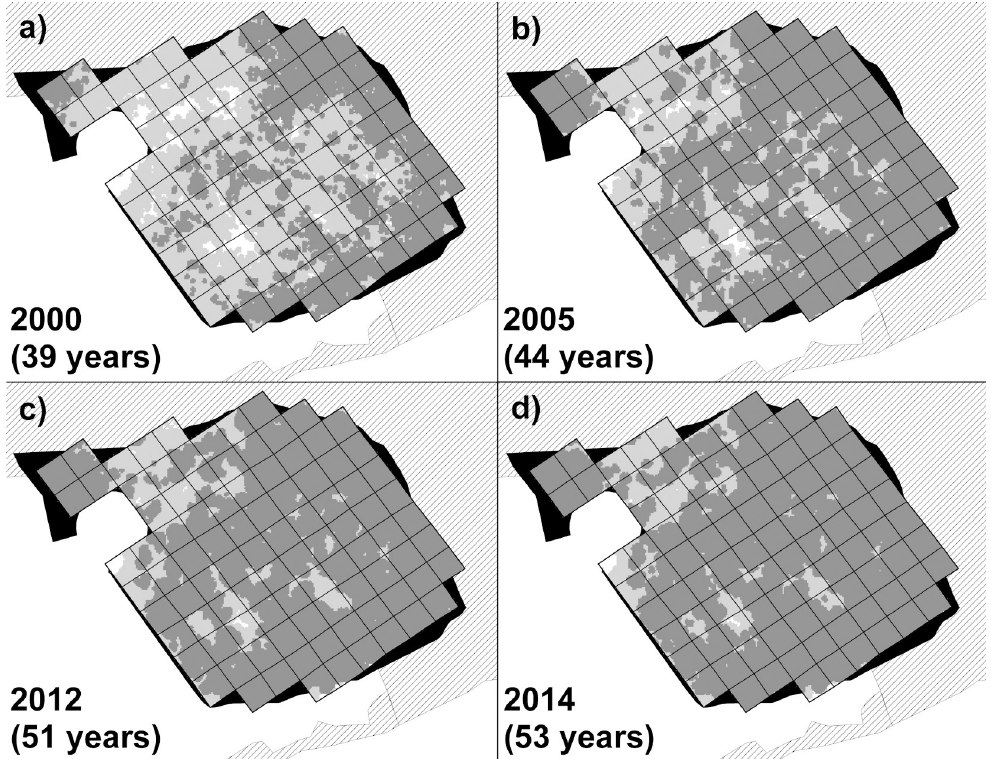
Fig 2. Development of the Old Wilderness vegetation. a) to d): Time series of remote sensing (lidar) data for the Old Wilderness for data collected in a given year (and number of years since Wilderness abandonment in 1961). Pale grey areas denote extent of woody vegetation of � 0.5 m but below 8 m tall, dark grey areas denote vegetation � 8 m tall (overstorey tree canopy). White areas are grass/herb vegetation below 0.5 m tall. Black areas denote unstudied parts of the Old Wilderness area. Hatched areas are Monks Wood ancient woodland and associated mature hedgerow (see Fig 1). Grid cells are 20 x 20